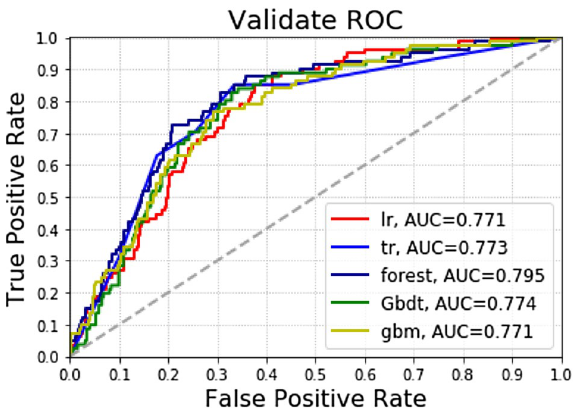
Figure 4. Different machine learning algorithms predict the recurrence of patients with gastric cancer after the operation in the test